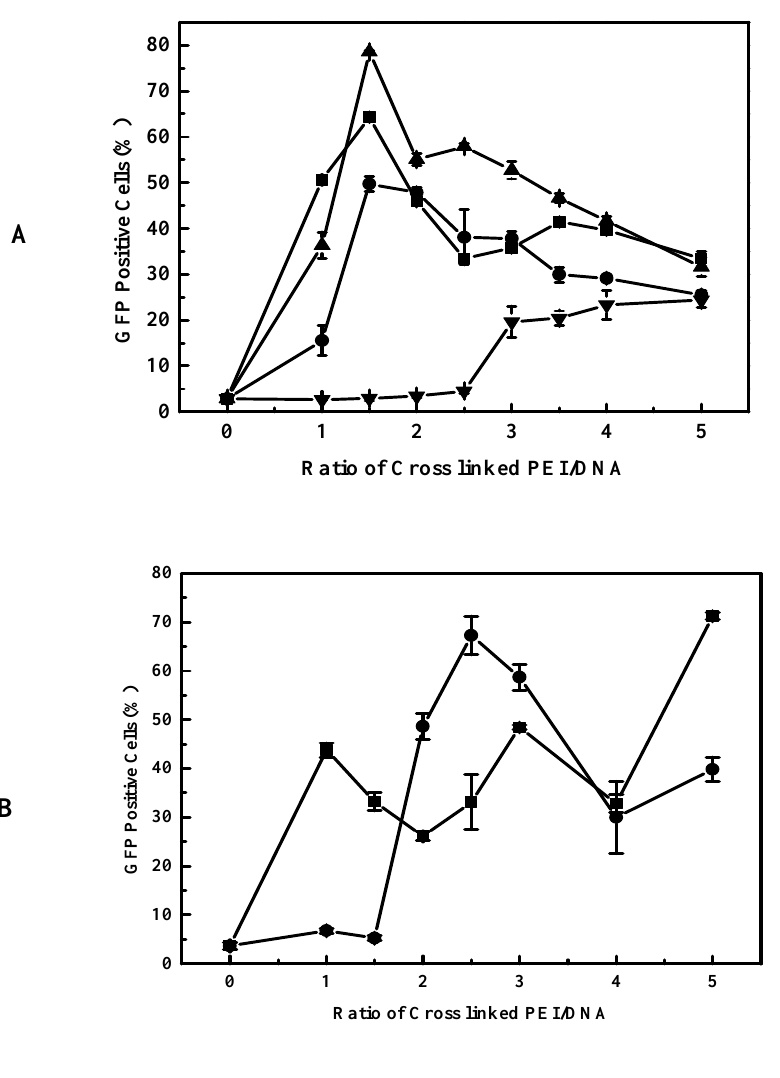
Figure 4. Gene transfection and expression efficiency of cross-linked PEIs in B16F10 cells. Cross- linked PEIs were used to complex 2 µ g DNA (pEGFP-C1) in PBS. B16F10 cells were incubated with the complexes for 4 h in serum-free medium, then the cell was incubated for 24 h in normal DMEM medium, and GFP expression was measured. (A) - ■ -: EGDMA-PEI2000-2h; - ● -: EGDMA-PEI2000- 3h; - ▲ -: EGDMA-PEI2000-4h; - ▼ -: EGDMA-PEI2000-6h. (B) - ■ -: BDDA-PEI2000-2h; - ● -: BDDA-PEI2000-4h. (N= 6, error bars represent standard